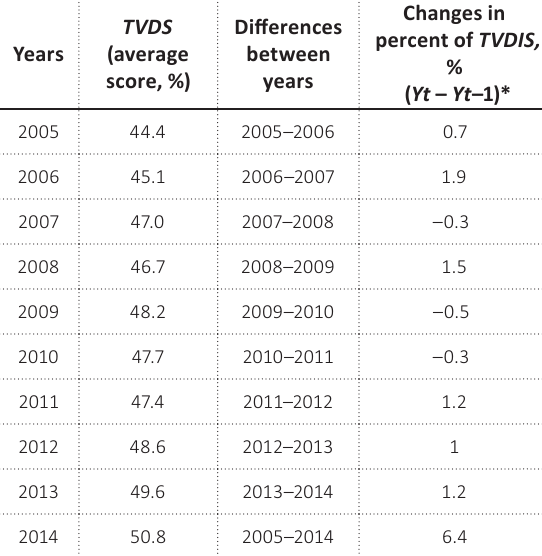
Table 5. Developments of the degree of TVDIS